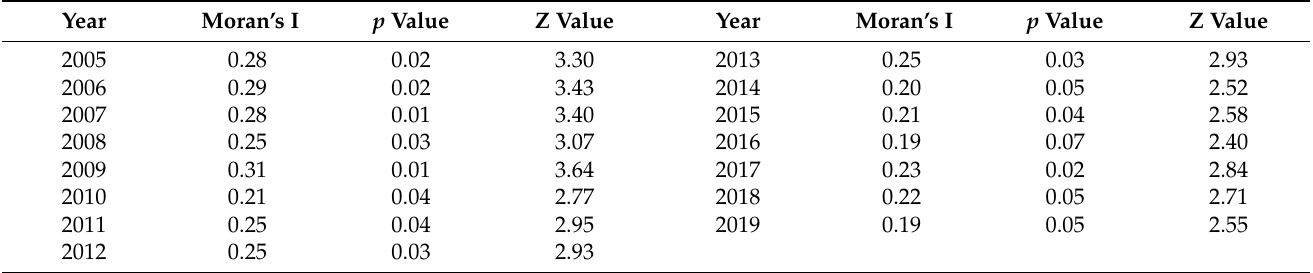
Table 7. The global Moran’I index of development level of open economy in YRDA from 2005 to